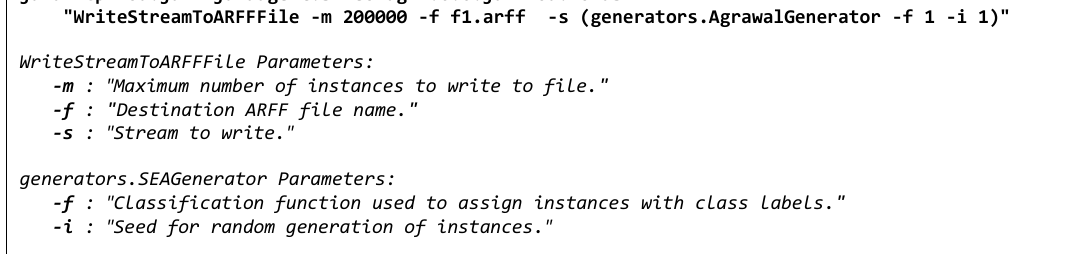
Figure 3. Command used to generate File 1 of AGR dataset. Table 3. Instances’ classes in every file in the AGR